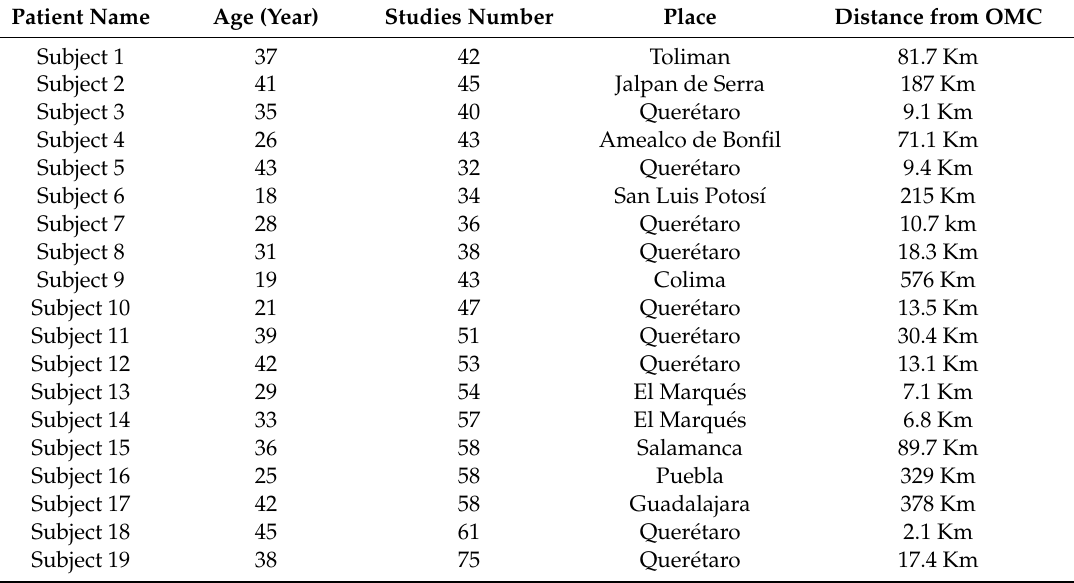
Table 1. Clinical Studies for approach validation.